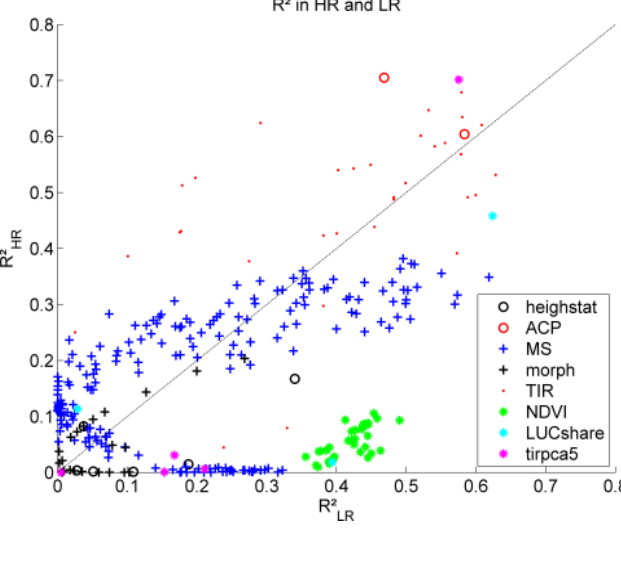
Figure 5. Explained variance R 2 of single predictors with LST in LR and